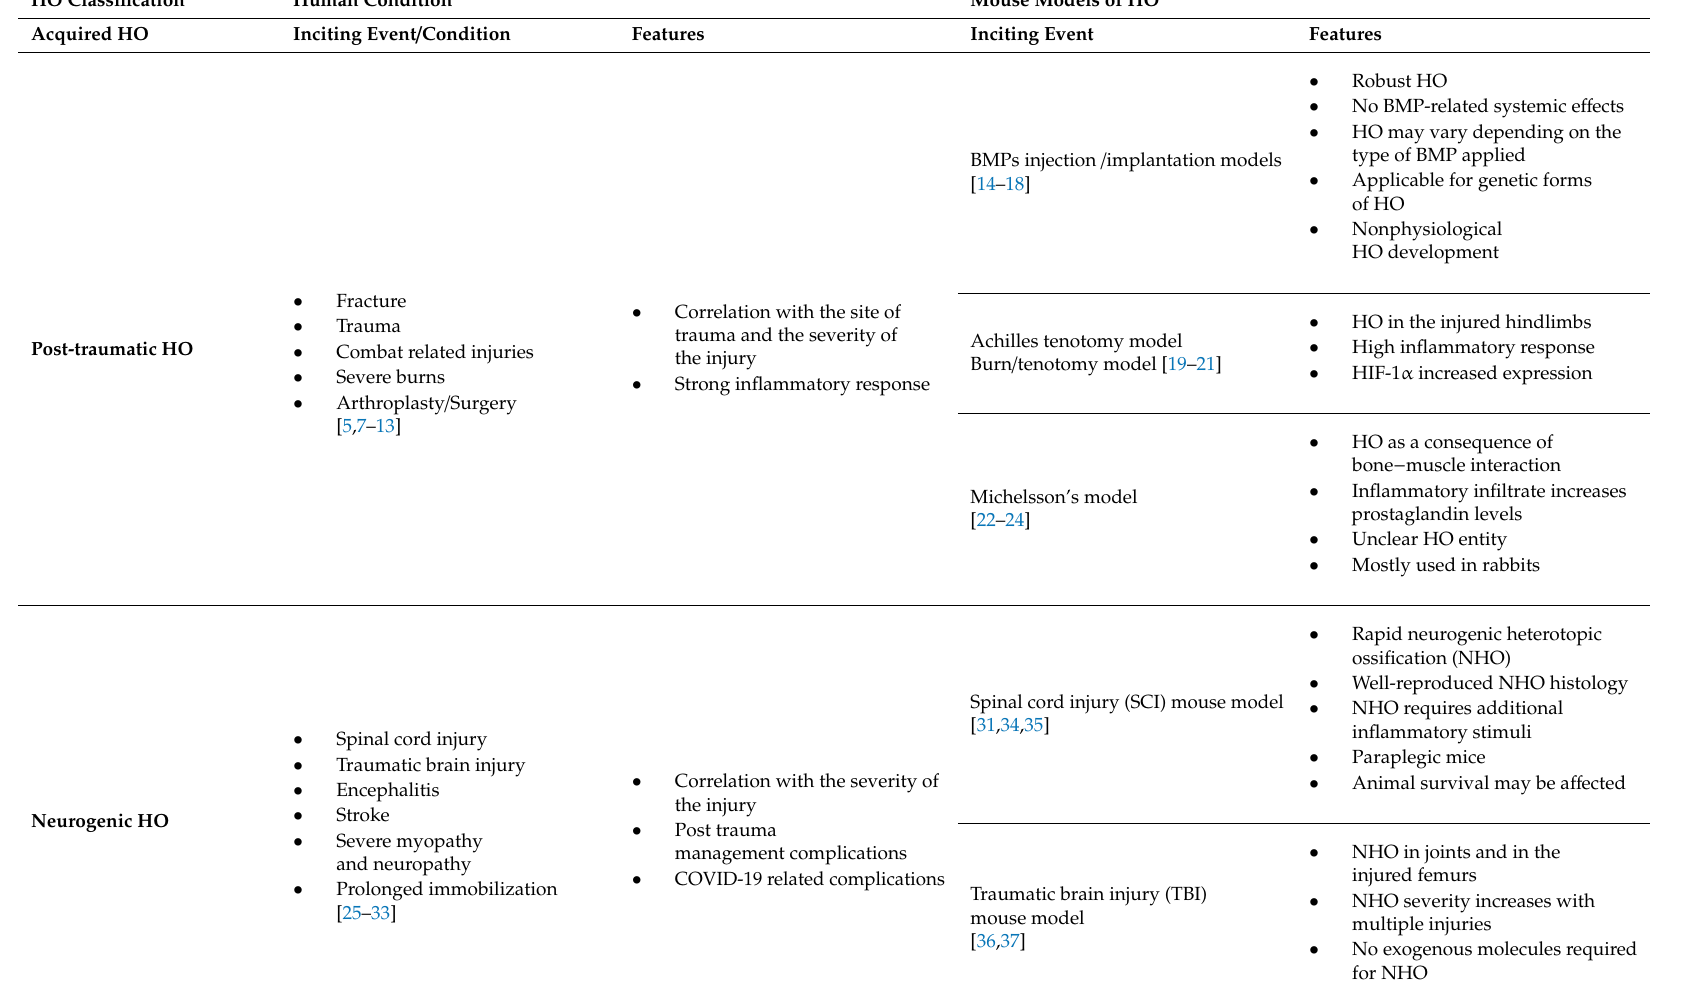
Table 1. Overview of the main forms of acquired and genetic Heterotopic Ossification (HO) in humans and comparison with the corresponding available mouse models. HO